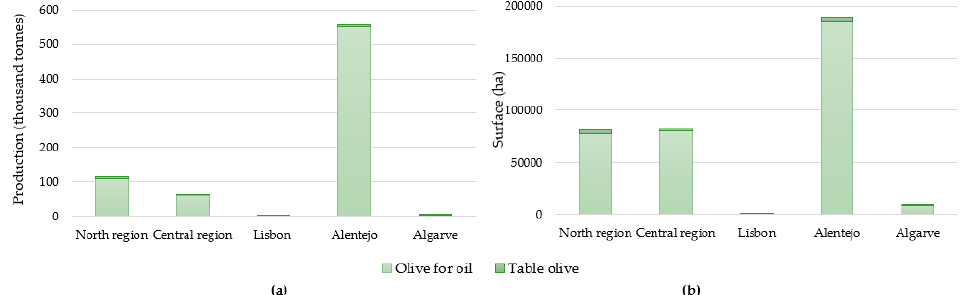
Figure 4. Production (thousand tons) and surface (ha) of olives for oil and table olives by NUTS (nomenclature of territorial units for statistics). Provisory data from the campaign year 2018/2019: ( a ) Portuguese production of olives for oil and table olives; ( b ) surface of olives for olive oil and table olives occupied in Portugal (data from INE [13]).